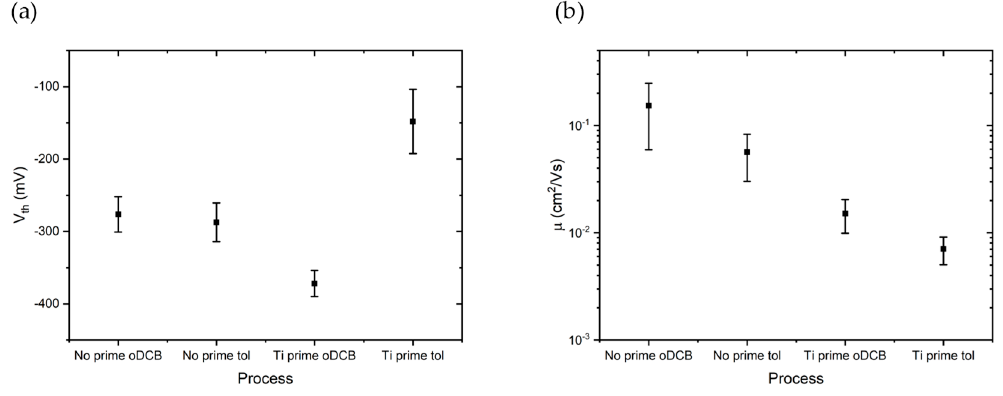
Figure 7. ( a ) Threshold voltage extrapolated from transfer characteristics of five devices for each process. ( b ) Field e ff ect mobility obtained from output characteristics in linear regime of five devices for each